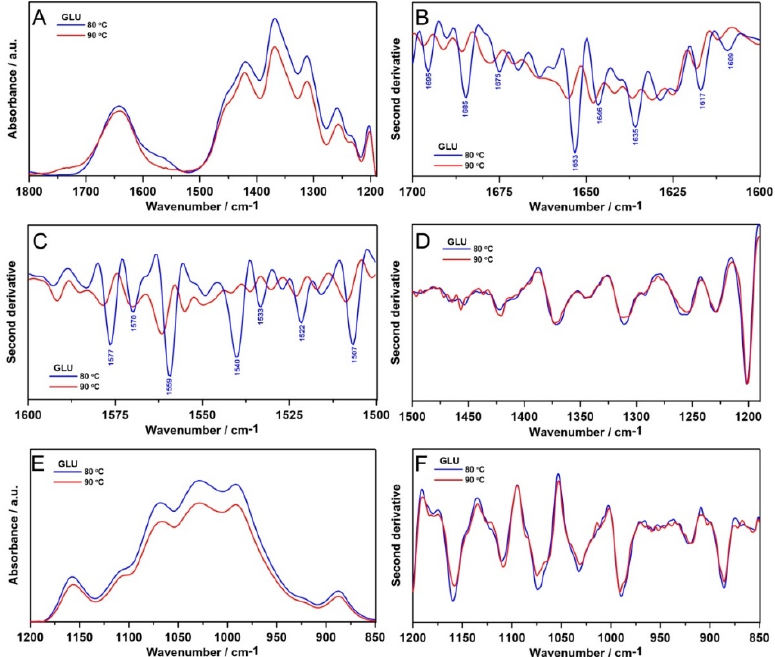
Figure 3. The relative intensity of ATR FT-IR spectra in the 1800–1200 cm − 1 range ( A ), the second derivatives of the ATR FT-IR spectra in the range of 1700–1600 cm − 1 ( B ), 1600–1500 cm − 1 ( C ), 1500–1190 cm − 1 ( D , fingerprint region specific for carbonyl groups in samples), the relative intensity of ATR FT-IR spectra in the 1200–850 cm − 1 range ( E , specific region for ring-structured carbohydrates) and the second derivatives in this spectral range ( F ).